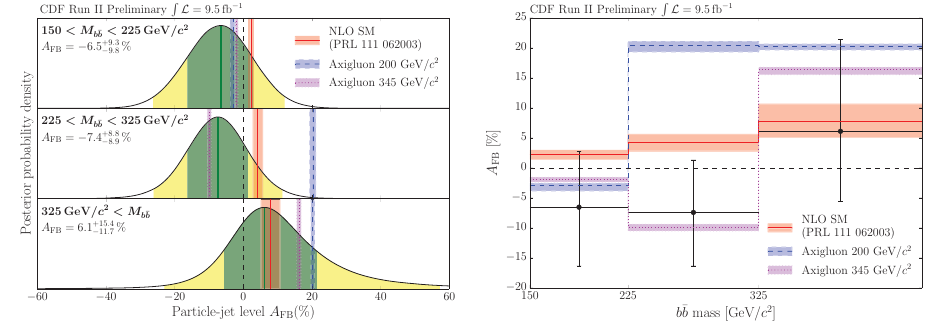
Figure 5. Measurement of the bottom pair forward-backward asymmetry at CDF, in two alternative representa- tions of its dependence on the bottom pair invariant